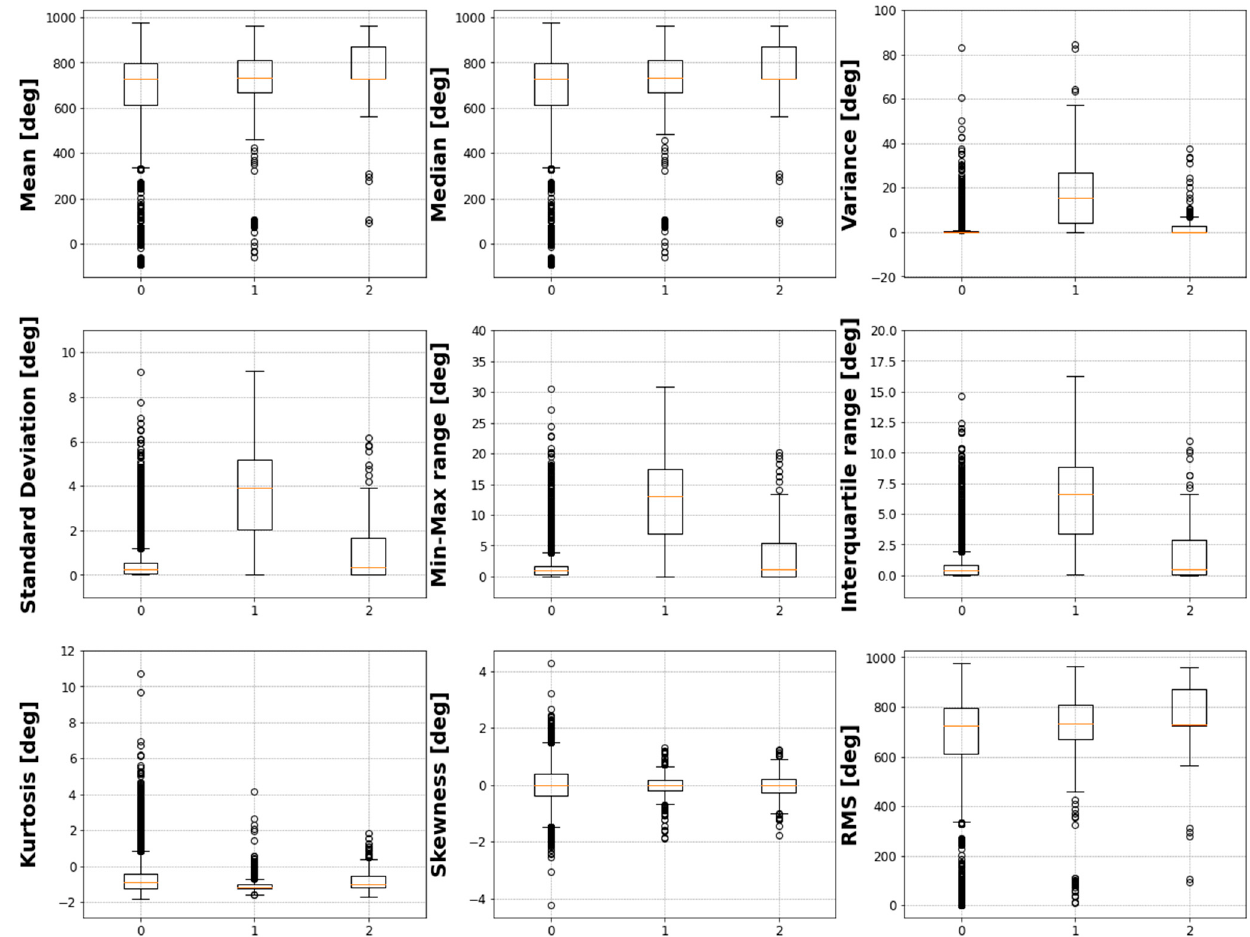
Figure 4. Boxplots of the initially proposed statistical indexes divided by selected classes.